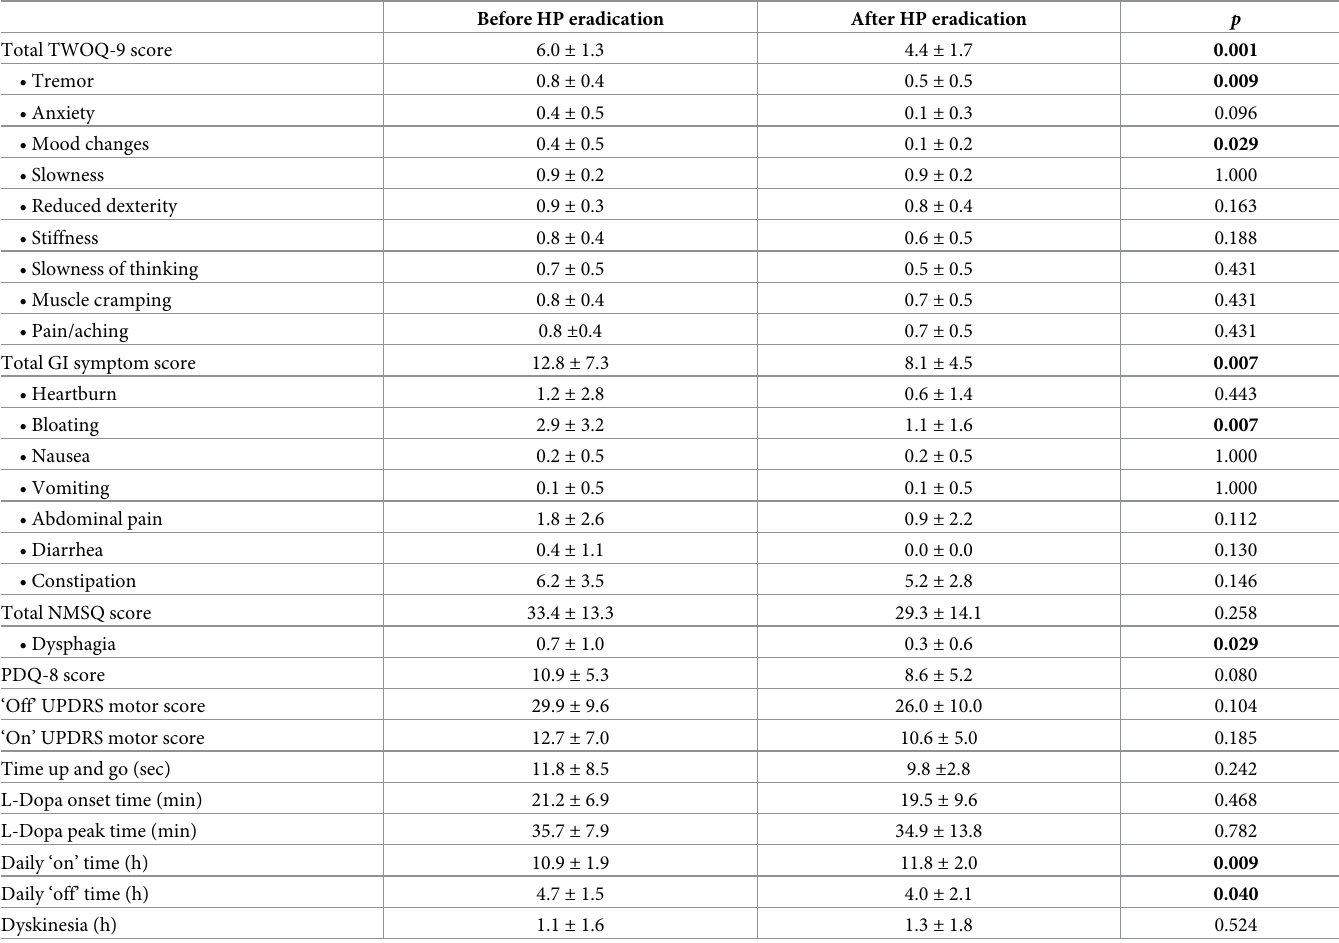
Table 2. Clinical symptoms before and after successful Helicobacter pylori (HP) eradication ( n =